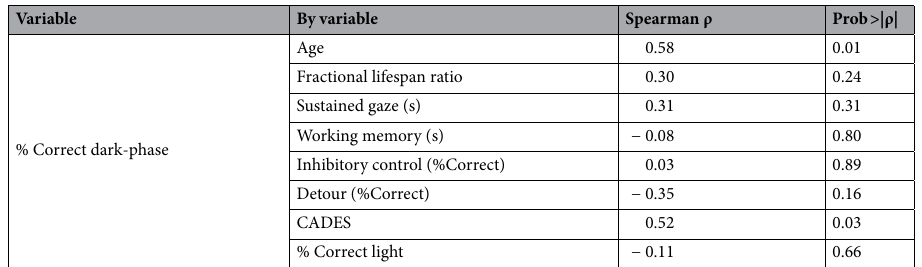
Table 3. Multivariate analysis of cognitive tests and CADES scores in the senior/geriatric group of dogs compared to their percent of correct choices in the dark-phase. Nonparametric Spearman’s ρ are reported along with associated p-value. Significance is set at 0.006 to account for multiple comparsions.